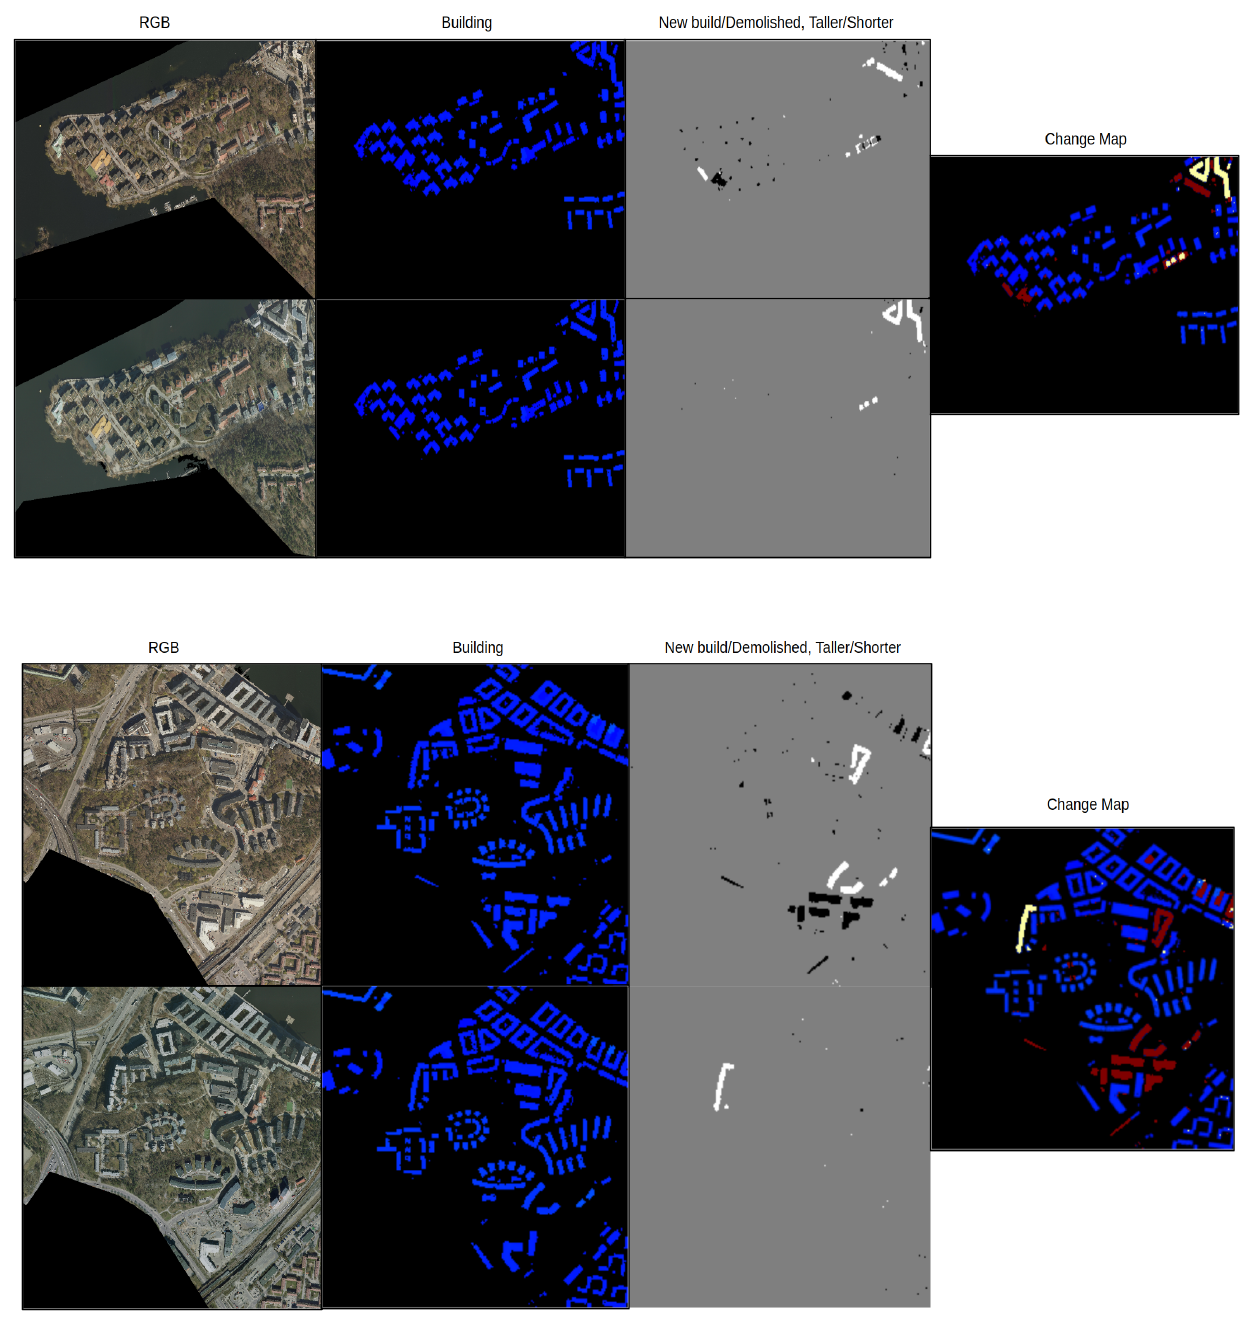
Figure 6. Change Detection Result